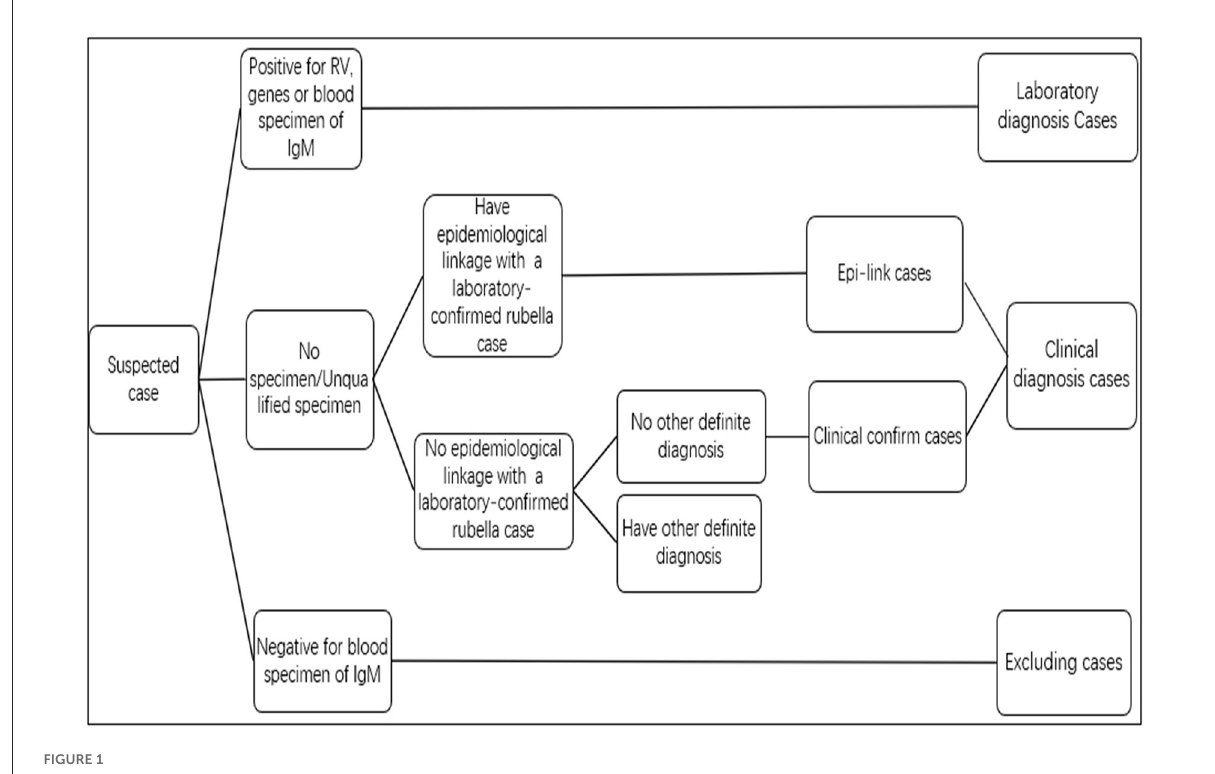
FIGURE1 Standard of the rubella suspected case